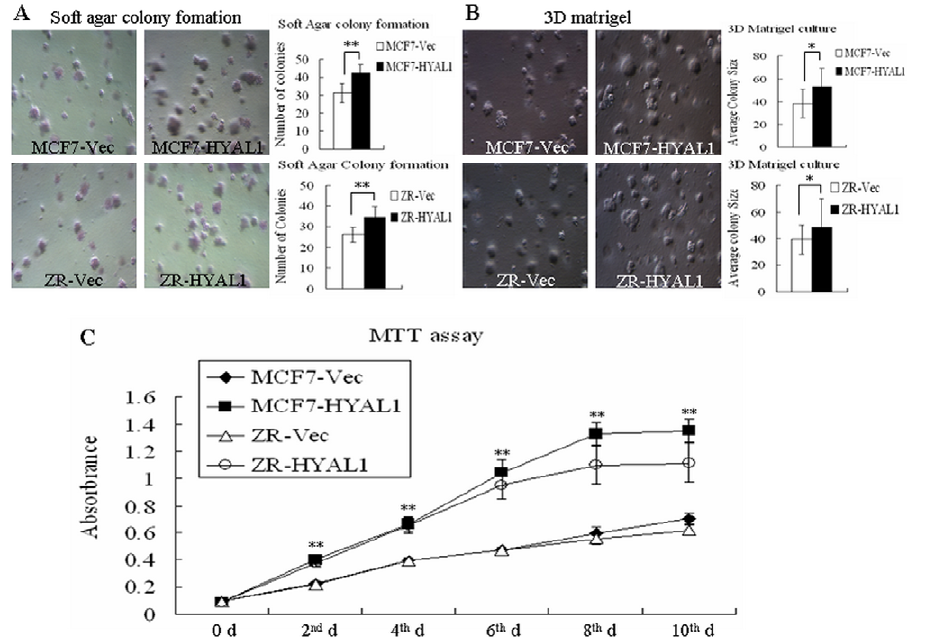
Figure 2. Upregulation of HYAL1 in breast cancer cells increased colony formation and enhanced cell proliferation. MCF7-HYAL1 and ZR-HYAL1 enhanced the number of colony formation in Soft agar (A) and size of colony in 3D Matrigel (B) ( p , 0.01, p , 0.05, respectively), (original magnification 6 100). MTT assay showed that MCF7-HYAL1 and ZR-HYAL1 increased cell proliferation rates (C; p , 0.01).